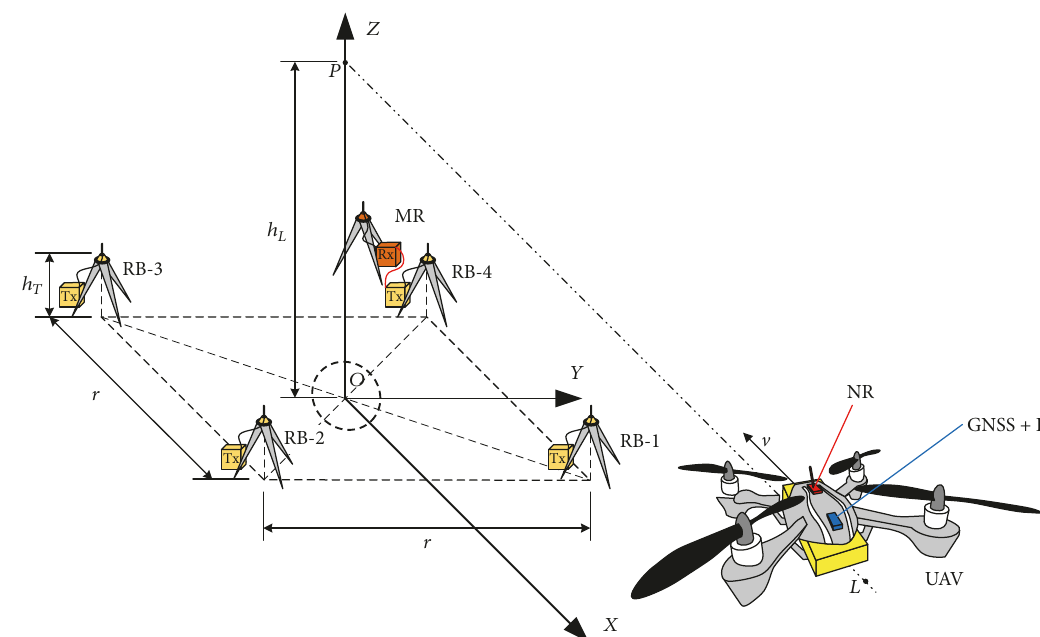
Figure 1: Structure of the automatic landing system.